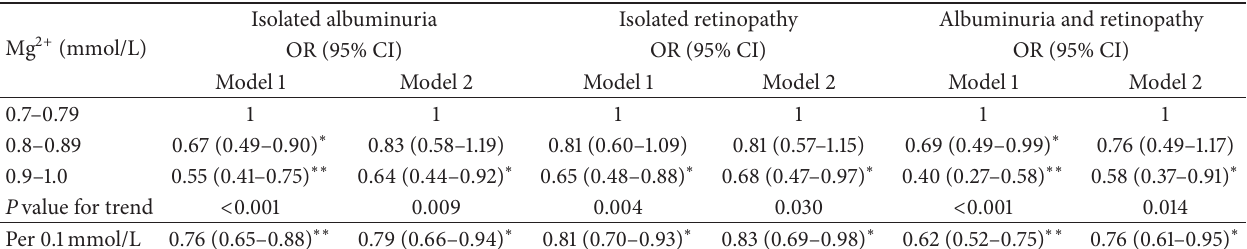
Table 2: Association of serum Mg 2+ with albuminuria and retinopathy.